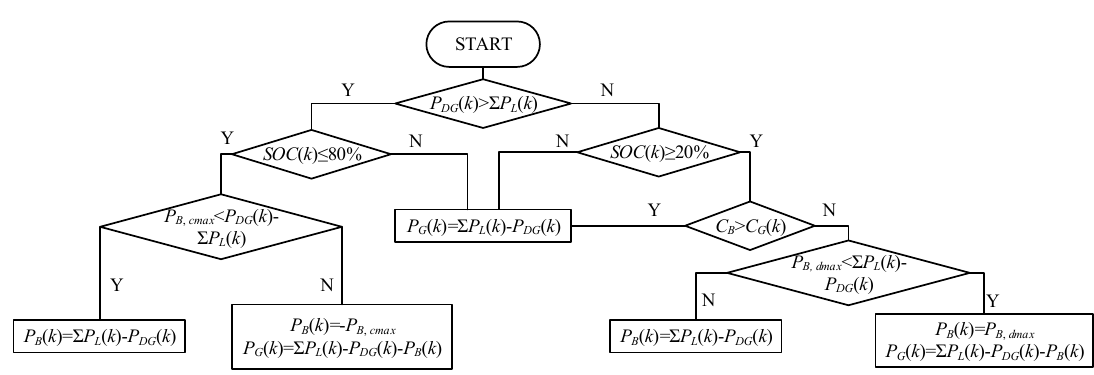
Figure 2. Flowchart of the power-supply-state judgment.